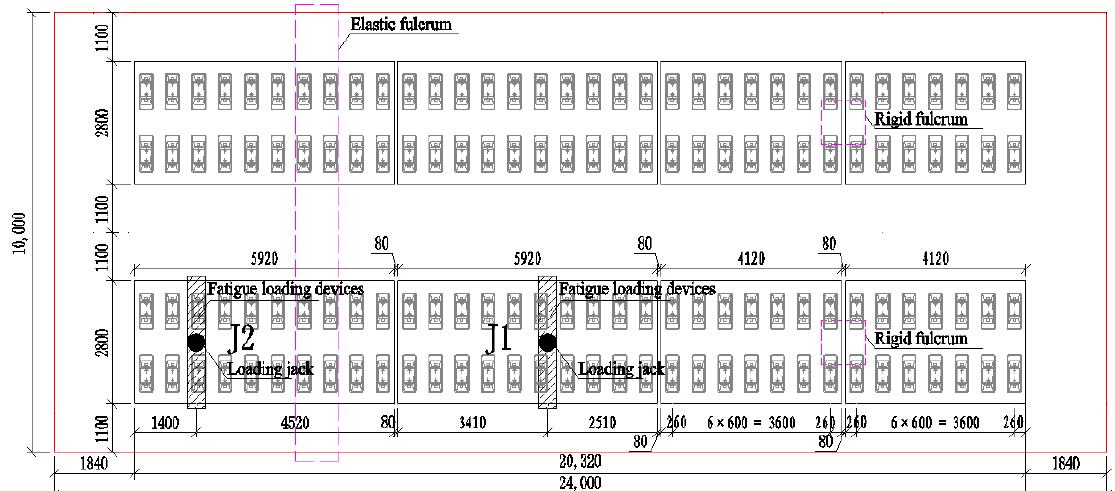
Figure 9. Loading positions of the two full-scale fatigue tests (unit: mm).